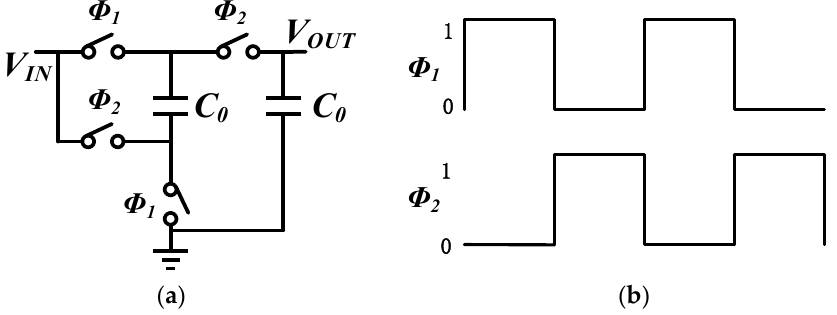
Figure 3. Makowski charge pump: ( a ) Schematic of 2X Makowski charge pump; ( b ) Non-overlapping clock.